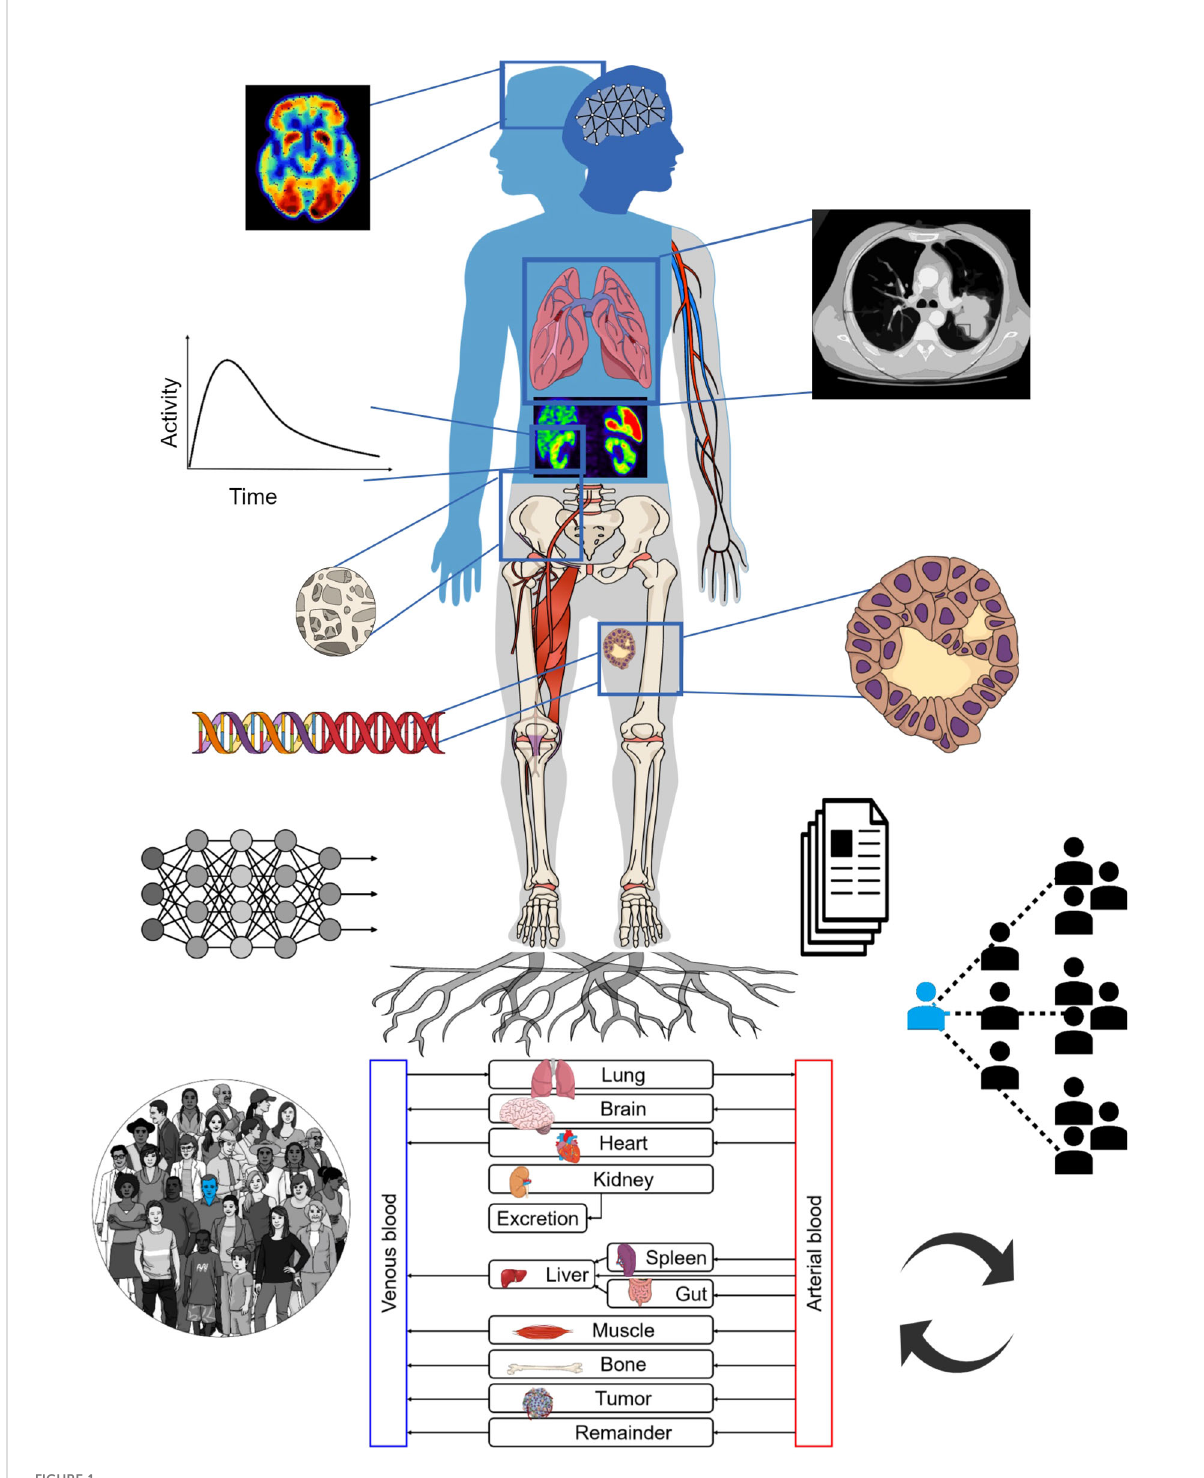
FIGURE 1 The TDT combines population-based knowledge with patient-speci fi c information such as medical imaging, tumor genomics, etc. It can utilize physiologically based pharmacokinetic (PBPK) modeling towards individual therapy planning. AI may assist in different steps including data extraction and inverse methods for personalization of TDTs. The TDT can be updated with new collected